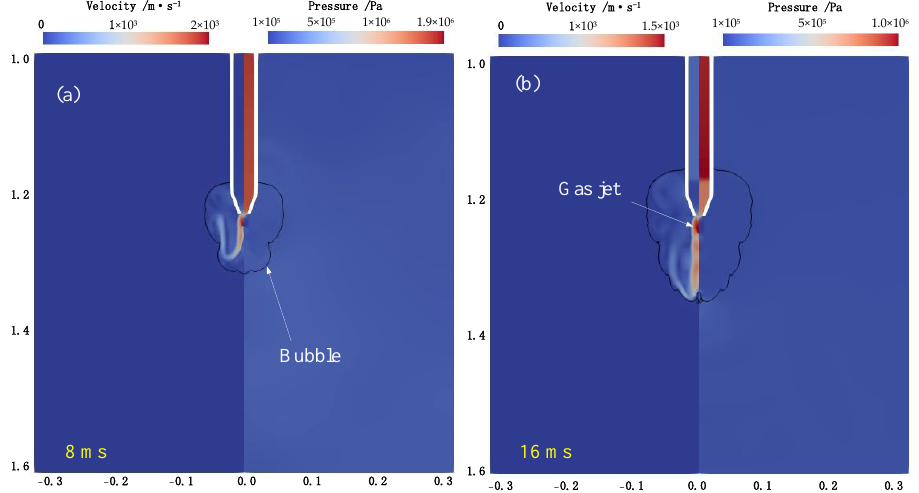
Figure 9. Simulation results of the bubble evolution process when the shrinking nozzle is installed: ( a ) t = 8 ms, ( b ) t = 16 ms.